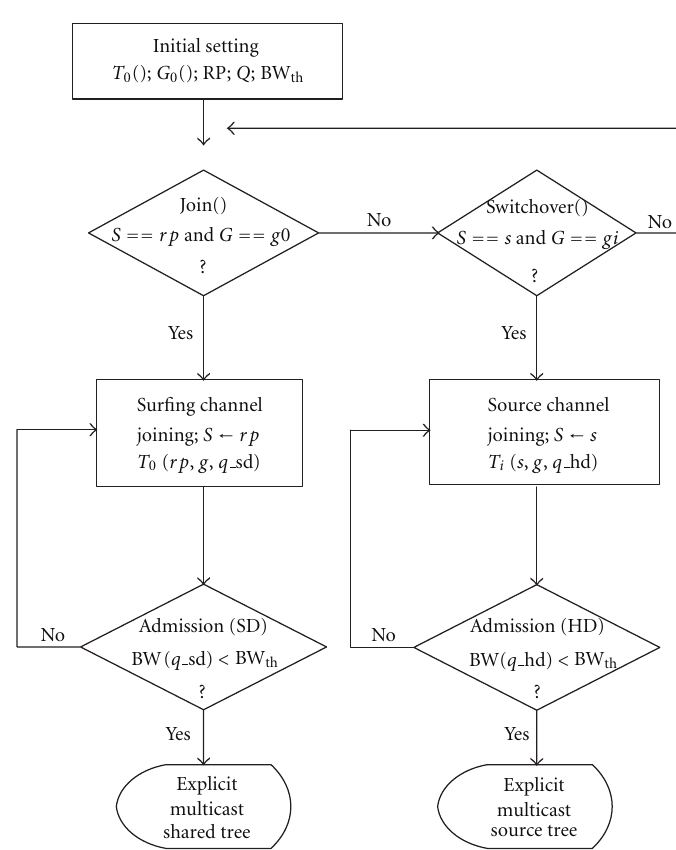
Figure 3: IPTV channel control algorithm for RP